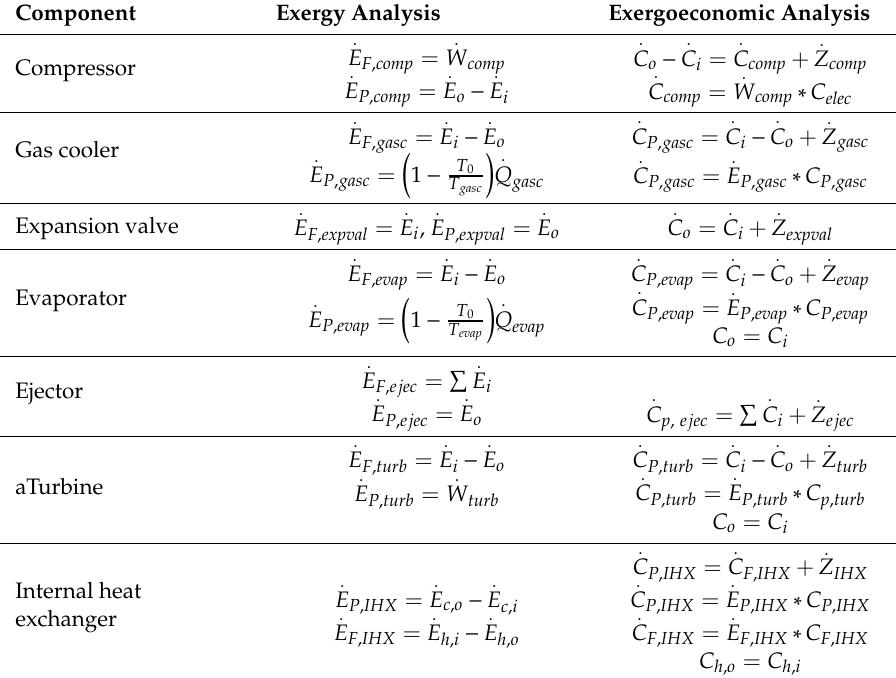
Table 3. Summary of the exergy and exergoeconomic equations for all refrigeration